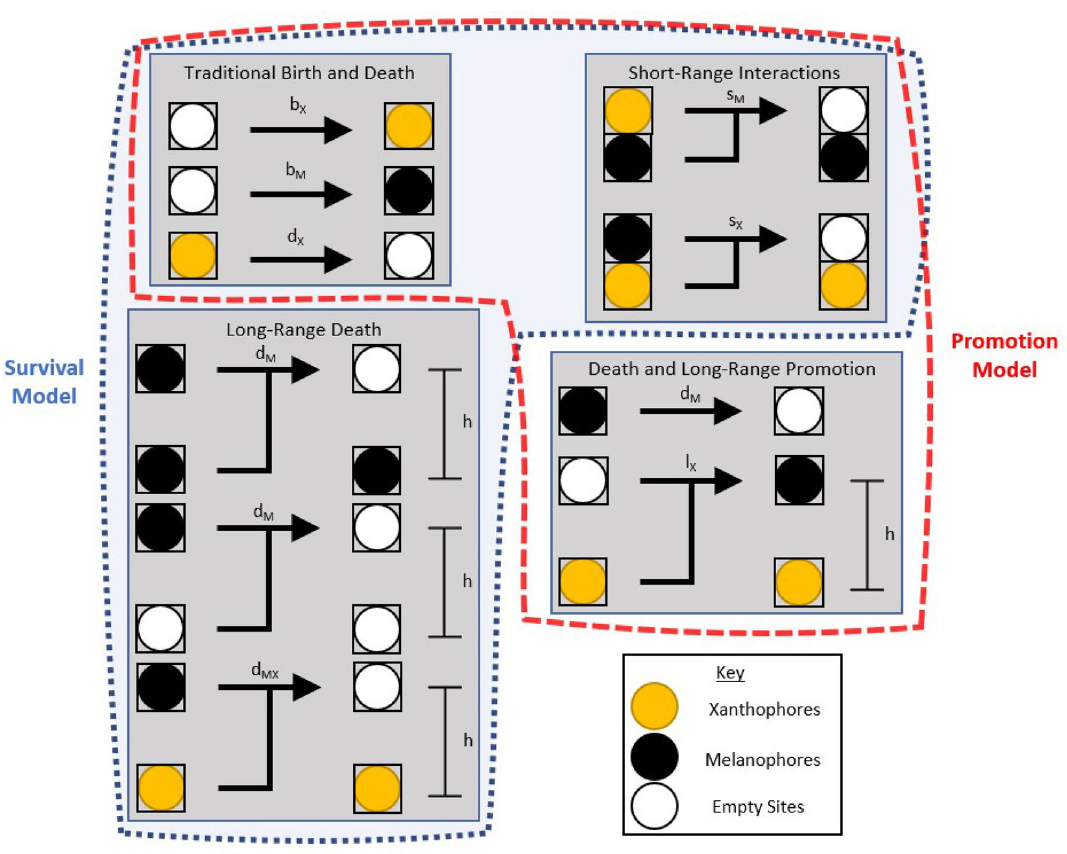
Figure 1. Schematic depicting the interactions of chromatophores in both the Promotion model and the Survival model of zebrafish skin pattern formation. The blue outline shows the Survival model, and the red outline shows the Promotion